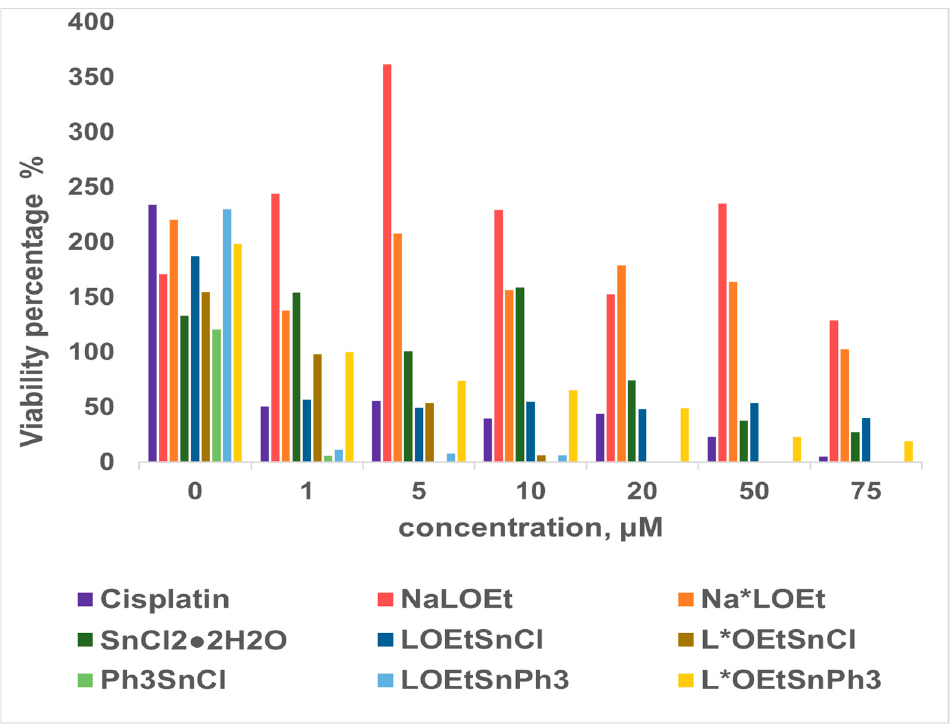
Figure 6. Viability percentage (%) values for organotin(II) and organotin(IV) complexes against the Jurkat T lymphoblastic tumor cell line.